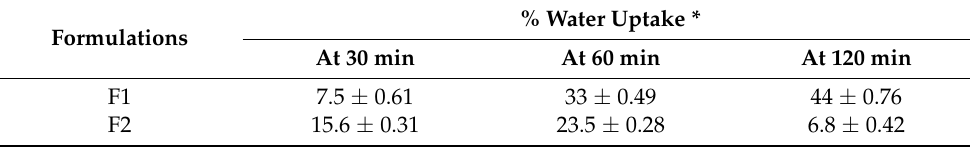
Table 9. Percentage water uptake study results of the oral raft-forming in situ gelling system of